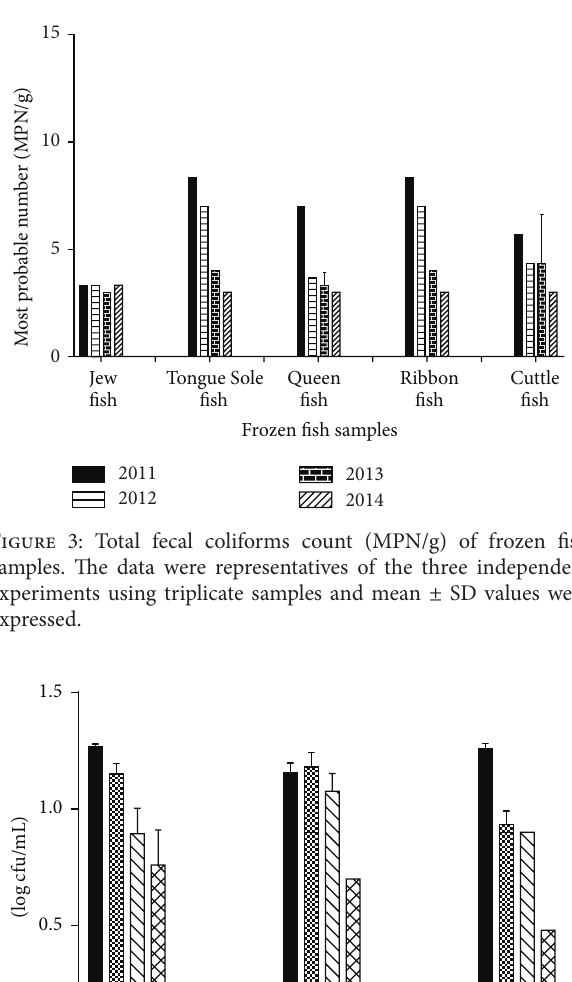
different processing steps such as transport and handling.